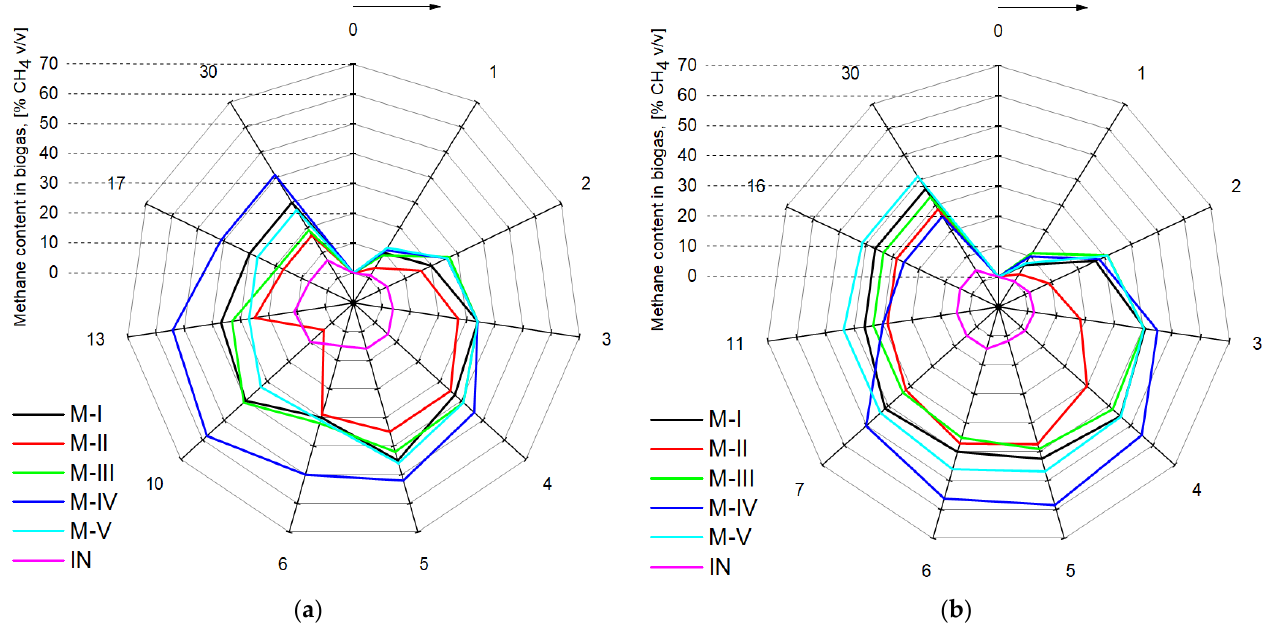
Figure 6. Variation of methane in biogas during 30-day digestion period: ( a ) mesophilic temperature; ( b ) thermophilic temperature.